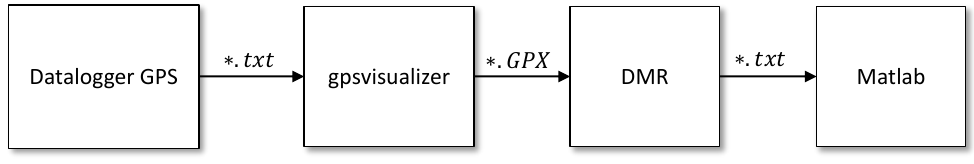
Figure 7. The test route visualized in OpenStreetMap ( left ) a DMR 5G ( right ).